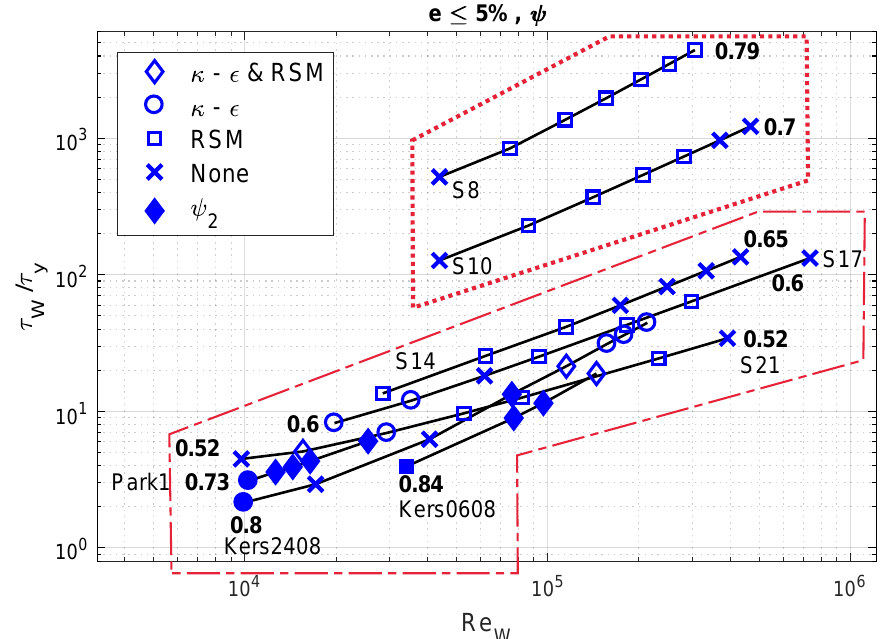
Figure 14. Performance of the standard RANS models combined with ψ 1 to achieve an error e ≤ 5%.